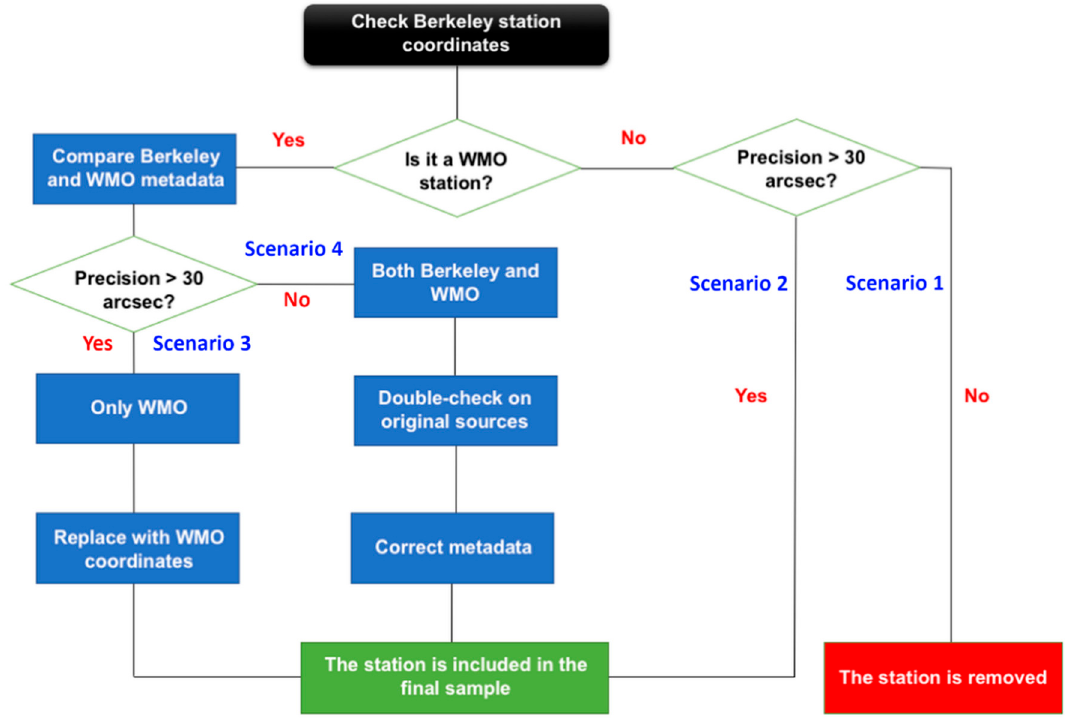
Figure 1. Flowchart showing the main steps of the procedure of geo-localization of air temperature stations from the Berkeley Earth dataset. In this figure, the Berkeley Earth dataset is abbreviated to Berkeley.